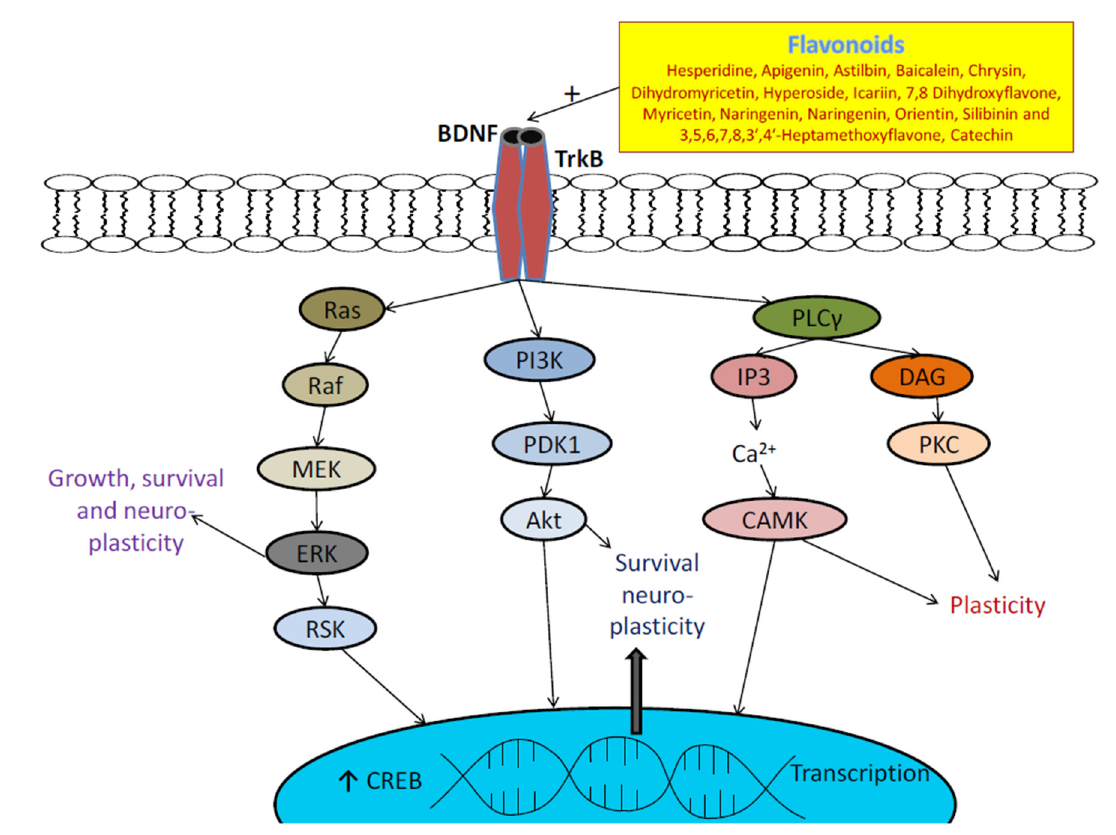
Figure 52. Effect of flavonoids on BDNF/TrkB signalling pathway . BDNF, brain-derived neurotrophic factor; TrkB, tropomyosin receptor kinase B; Ras, rapidly accelerated sarcoma; Raf, rapidly accelerated fibrosarcoma; MEK, mitogen-activated protein kinase; ERK, extracellular regulated kinase; RSK, ribosomal S6 kinase; P13K, phosphoinositide 3-kinases; PDK1, 3-phosphoinositide-dependent kinase 1; Akt(PKB), protein kinase B; PLC γ , phospholipase C gamma; IP3, inositol trisphosphate; CAMK, Ca2+/calmodulin-dependent protein kinase; DAG, diacylglycerol; PKC, protein kinase C; CREB, cAMP-response element binding protein.